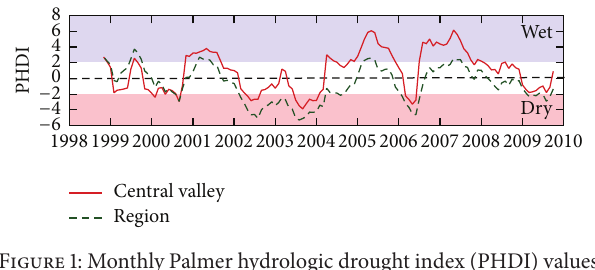
Figure 1: Monthly Palmer hydrologic drought index (PHDI) values averaged across the study area (central valley, solid line) and averaged across the central valley and upstream catchment (region, broken line).